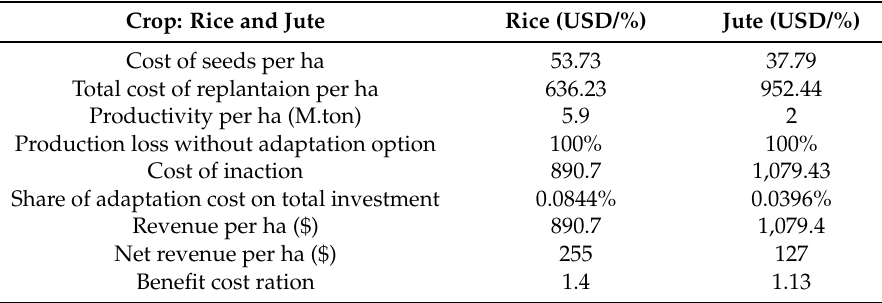
Table 6. Economic analysis of replantation.